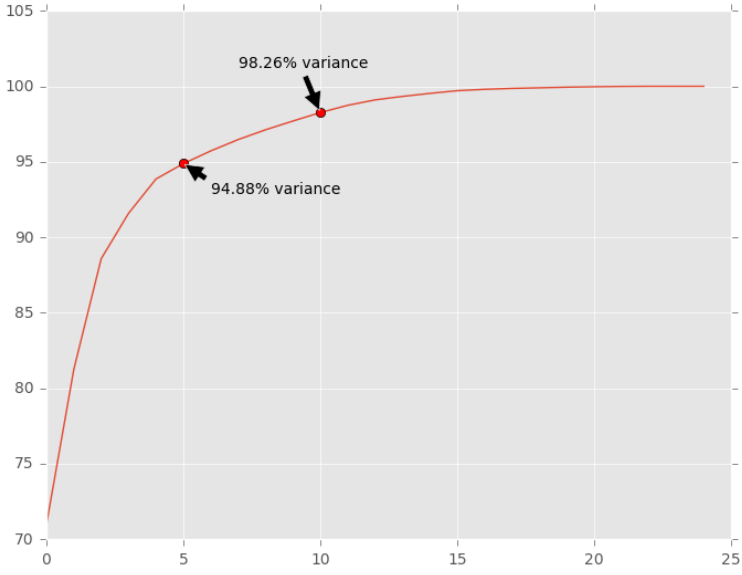
Figure 9. Scree plot showing components variance cumulative